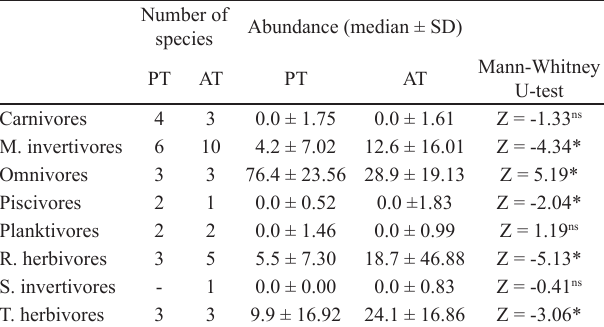
Table 2. SIMPER percentages of the top seven fish species that most contributed to the differences between PT (presence of tourists) and AT (absence of tourists) periods.